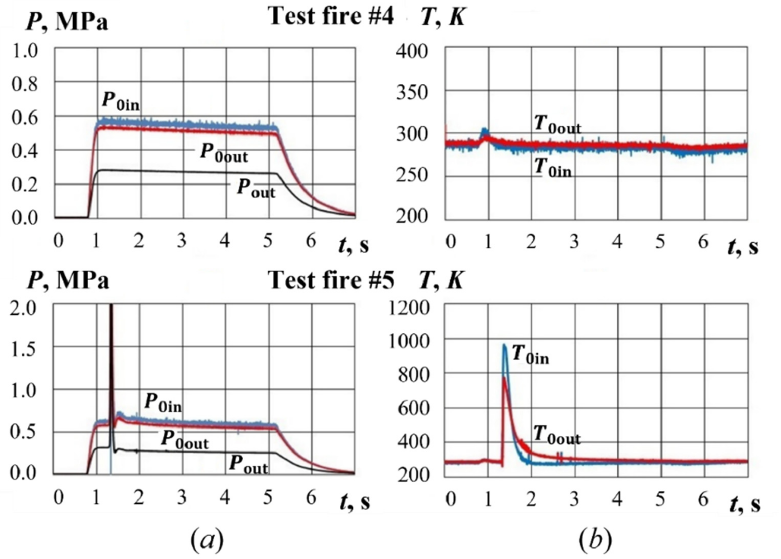
Figure 10. Time histories of ( a ) pressure and ( b ) temperature at PP sample inlet and outlet in test fires #4 and #5.